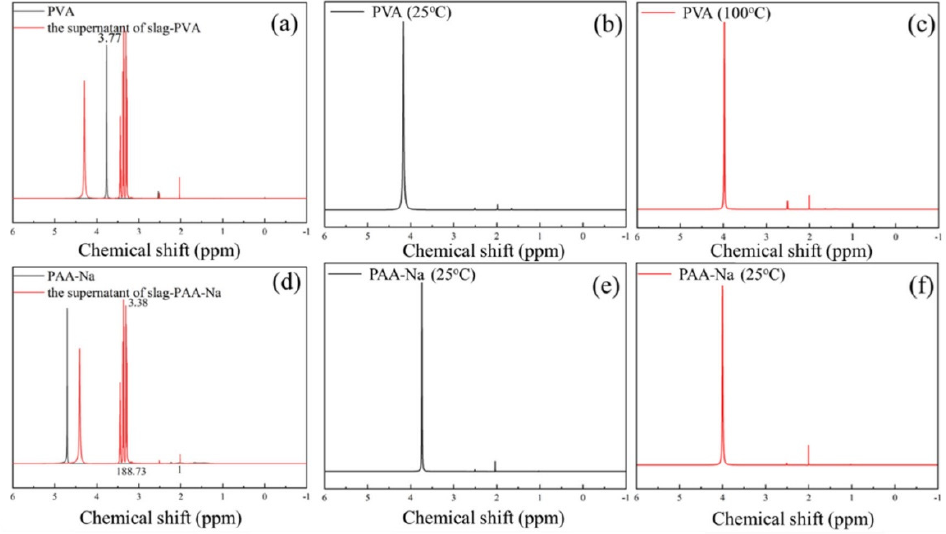
Figure 9. Liquid-state 1 H NMR spectrum of ( a ) PVA; ( b ) PVA (25 ◦ C); ( c ) PVA (100 ◦ C); ( d ) PAA-Na; Figure 9. Liquid ‐ state 1 H NMR spectrum of ( a ) PVA; ( b ) PVA (25 °C); ( c ) PVA (100 °C); ( d ) PAA ‐ Na; ( e ) PAA ‐ Na (25 °C); ( f ) PAA ‐ Na (100 °C). ( e ) PAA-Na (25 ◦ C); ( f ) PAA-Na (100 ◦